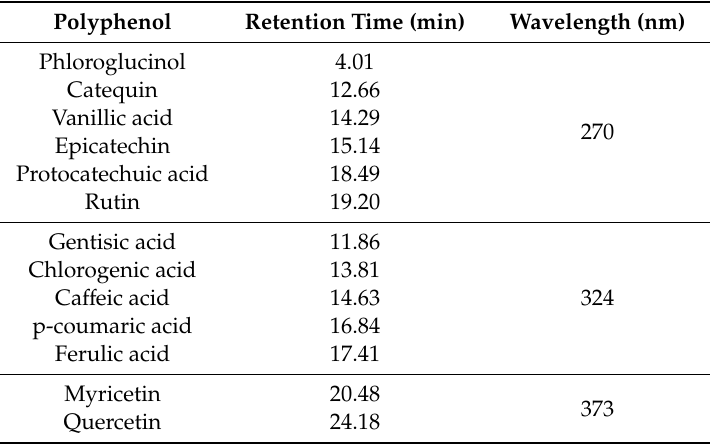
Table 1. Retention times and wavelengths for the polyphenols standard